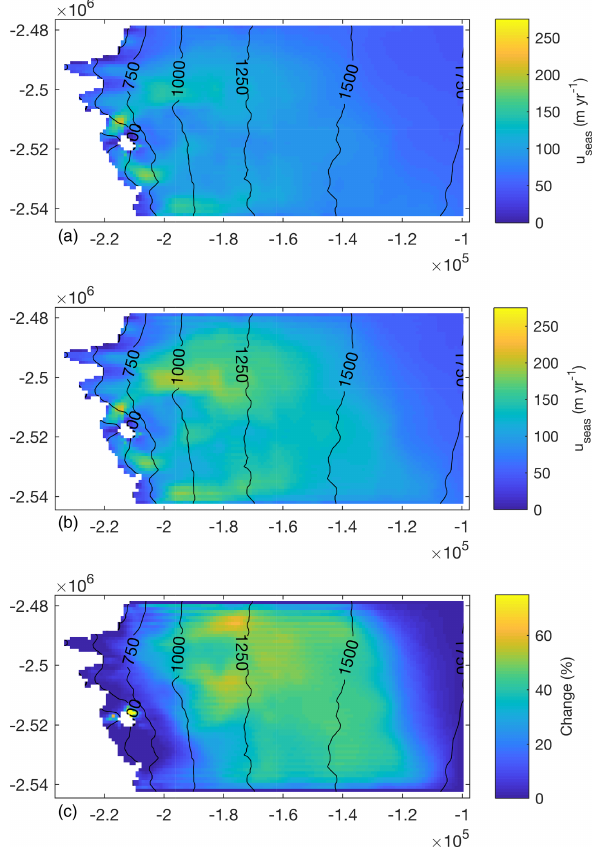
Figure 11. (a) Map of melt season average velocities for 2009. (b) Map of melt season average velocities for 2011 × 4 . (c) Change (%) between the melt season average velocities of 2009 and 2011 × 4